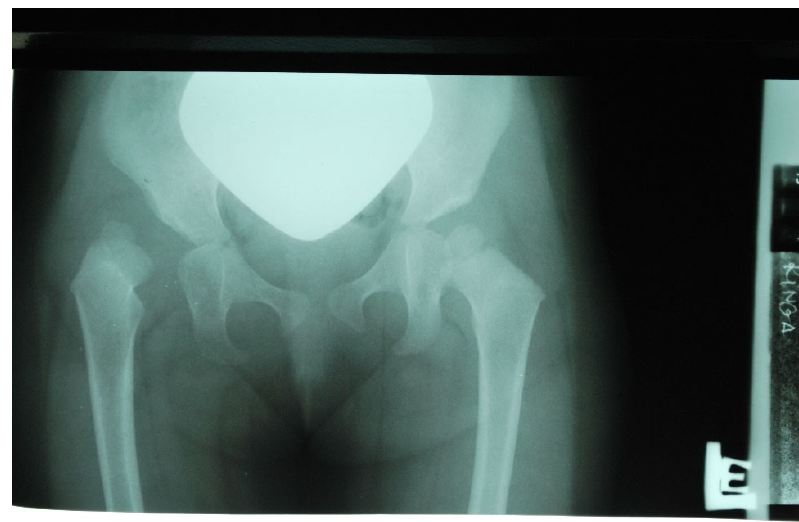
Figure 3. X ‐ ray scan showing right hip dislocation in the girl (at 2 years of age). Figure 3. X-ray scan showing right hip dislocation in the girl (at 2 years of age). Following orthopedic consultation, the girl qualified for surgical treatment (recon ‐ struction of the right hip joint with corrective rotational femoral osteotomy on the right side).